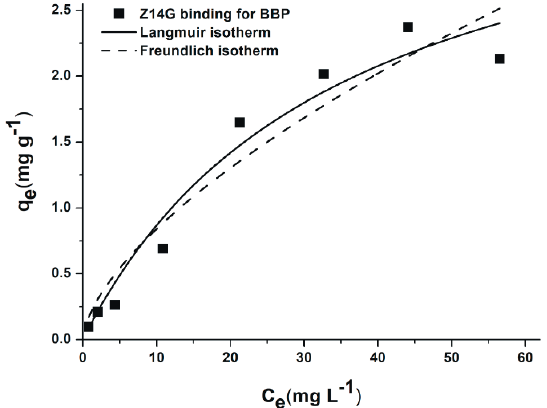
Figure 9. Langmuir (solid line) and Freundlich (dashed line) isotherms for the Z14G binding of BBP in 0.05 M sodium acetate buffer (pH 5.0; see further details in section 2.4.).